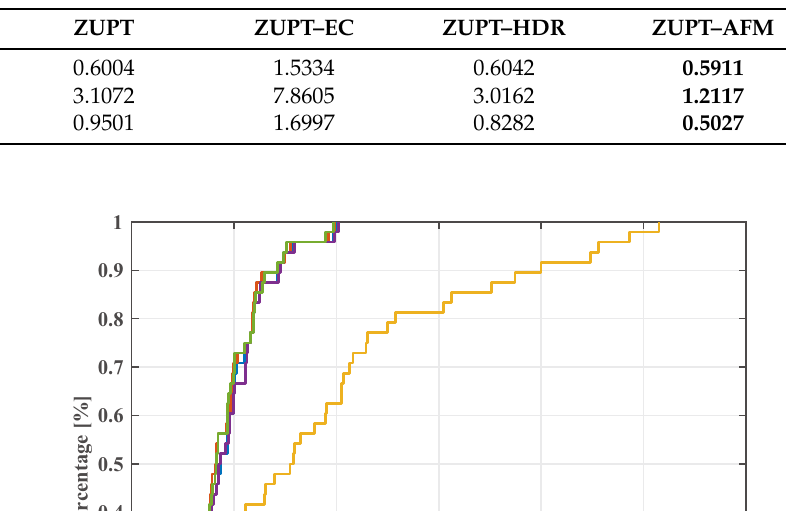
Table 7. Performance of the different frameworks on all indoor and outdoor loop datasets. Each bold number refers to the optimal performance in each row.